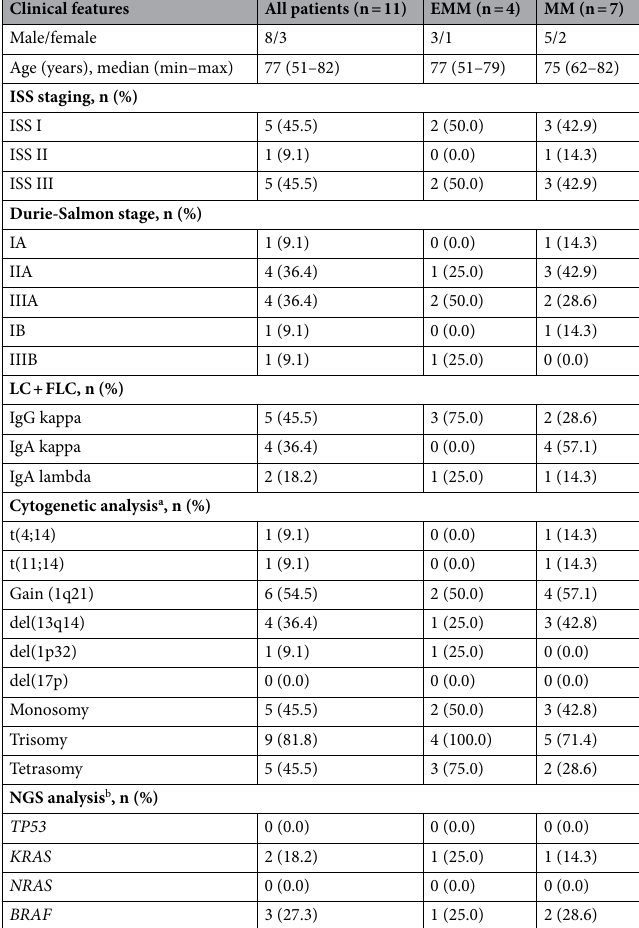
Table 1. Basic demographic and clinical characteristics of enrolled MM and EMM patients. ISS International Staging System, LC monoclonal protein’s light chain, FLC free light chain. a 10% positive cut-off level used. b The full coding sequence of the TP53 gene (exons 2–11, plus 5 ′ and 3 ′ UTR; NM_000546) and the hotspot